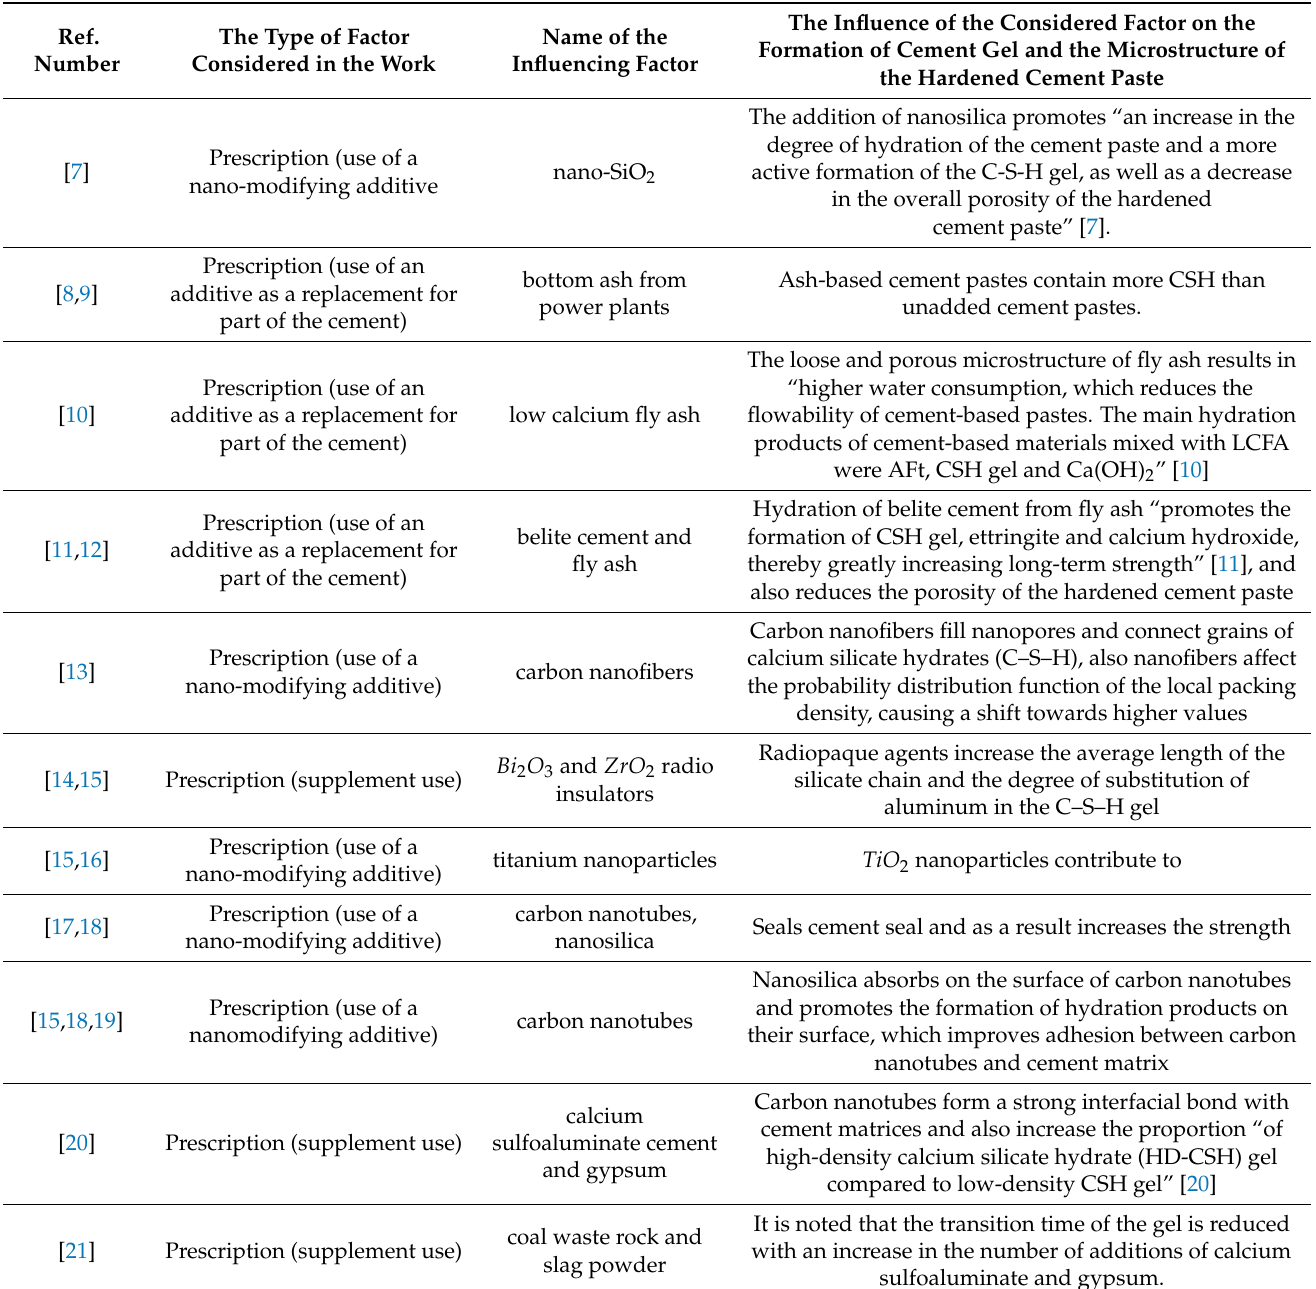
Table 1. Influence of various factors on the formation of cement